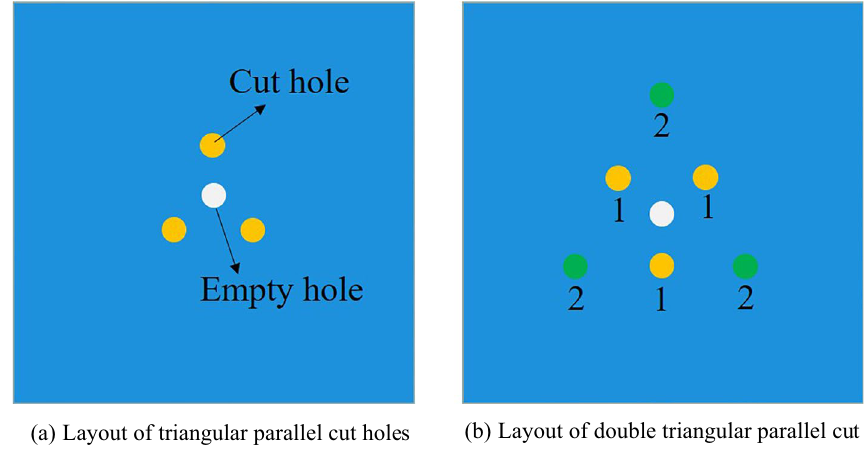
Fig. 1 Layout of cut holes. a Layout of triangular parallel cut holes b Layout of double triangular parallel cut holes